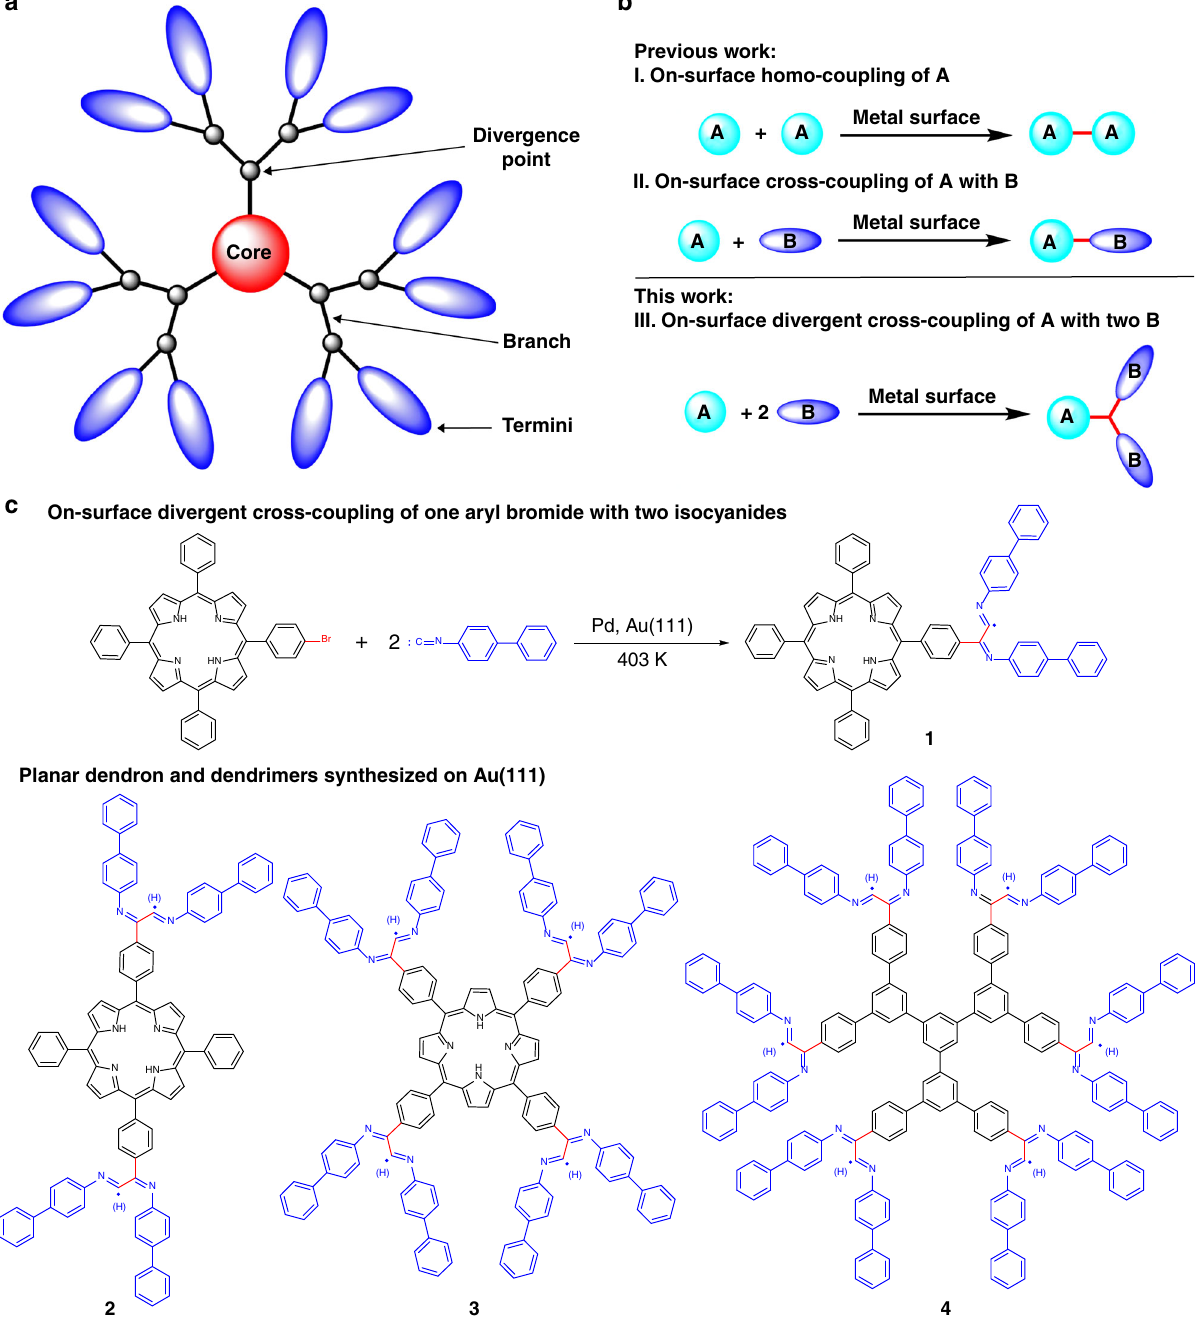
Fig. 1 On-surface synthesis of planar dendrimers via DCR. a The general structure of a dendrimer. b On-surface coupling reactions. c On-surface synthesis of planar dendron ( 2 ) with four branches and dendrimers ( 3 and 4 ) with eight and twelve branches (the products might be surface-bonded radicals or hydrogenated